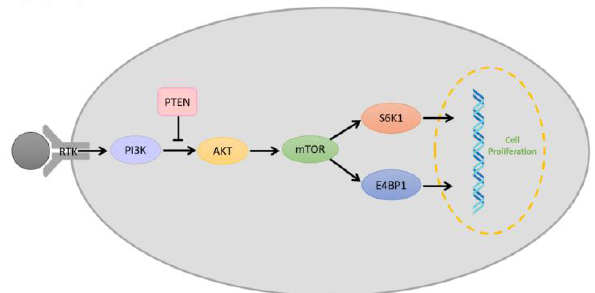
Figure 3. Schematic representation of a simplified overview on the PI3K/AKT/mTOR pathway